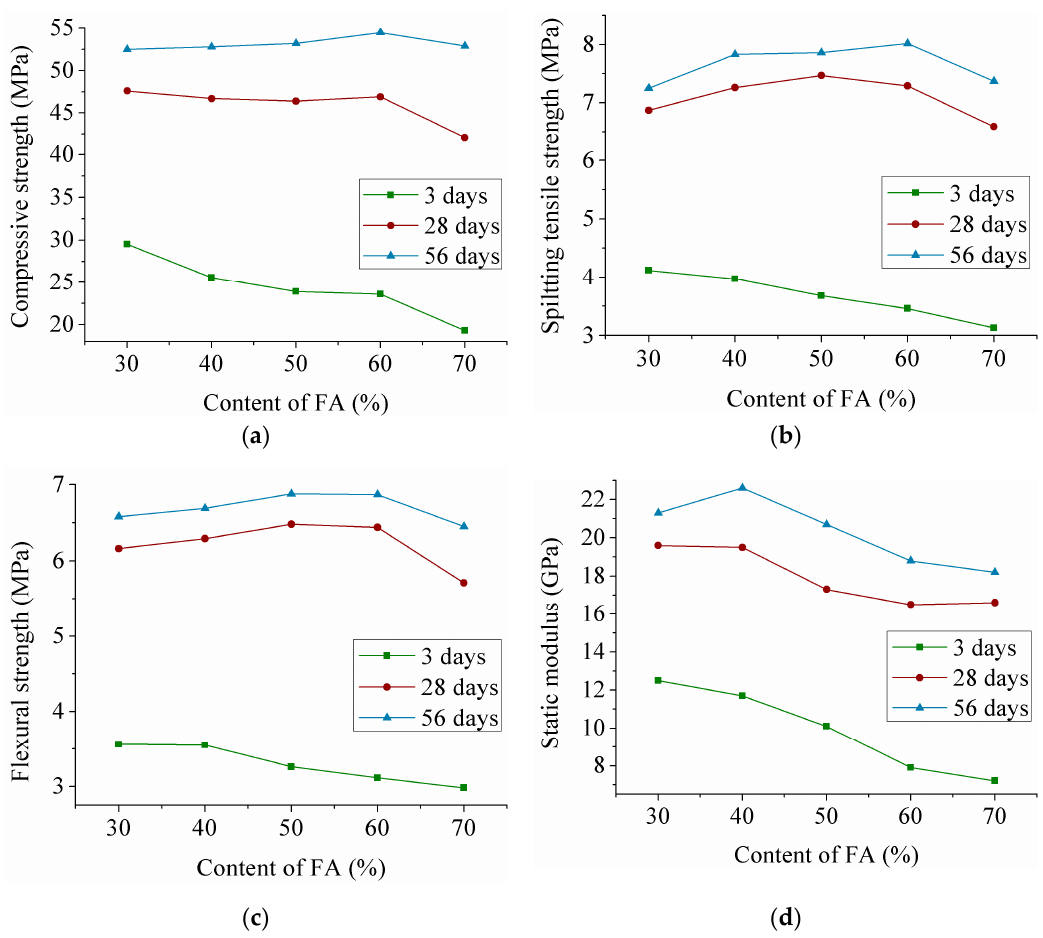
Figure 3. Mechanical properties of BF-ECC for different FA content. ( a ) Effect of the FA content on the compressive strength; ( b ) Effect of the FA content on the splitting tensile strength; ( c ) Effect of the FA content on the flexural strength; ( d ) Effect of the FA content on the static modulus.